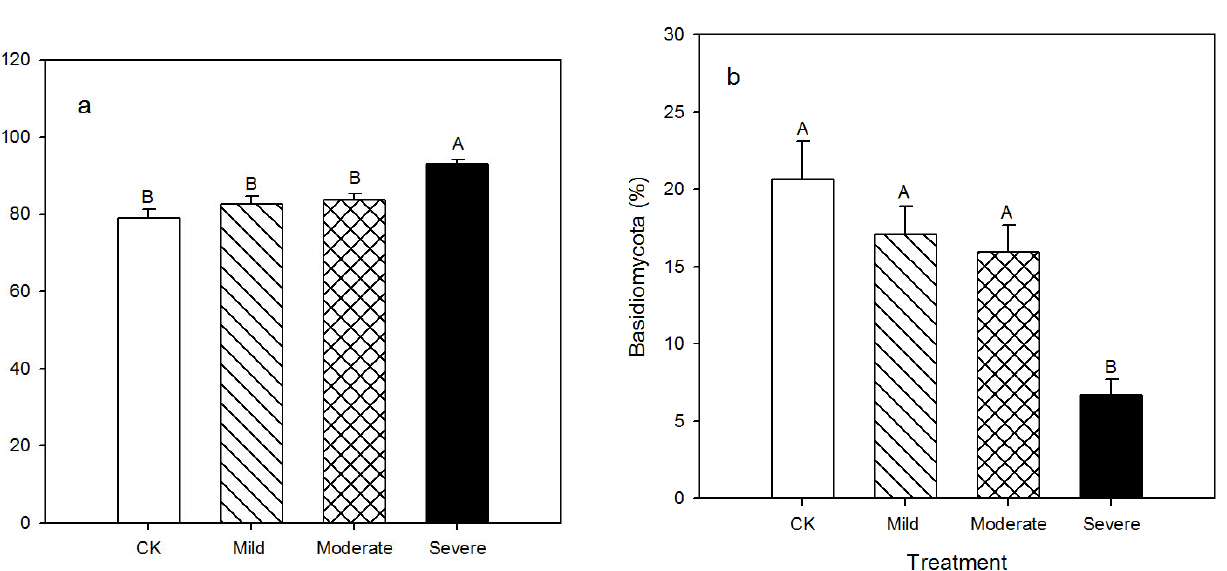
Figure 4. Principal coordinate analysis (PCoA) of endophytic fungal dissimilarity (Bray–Curtis). The Ascomycota and Basidiomycota phyla were the dominant fungi and showed relative abundances ranging from 78.99% to 93.10% and from 6.70% to 20.61% across all the samples, respectively (Figure 5). Compared with the CK treatment, the severe salt stress